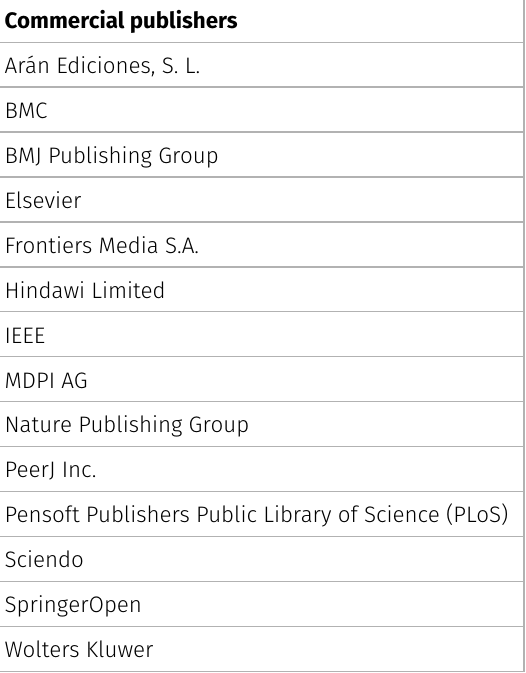
Table II. Commercial publishers considered in the survey. (Web of Science